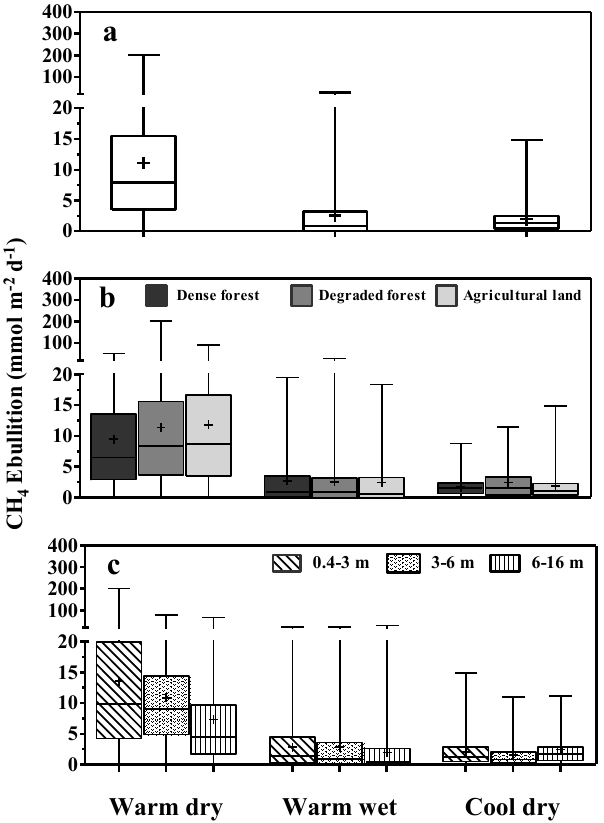
Figure 7. Ebullition measured by funnels for (a) the three different seasons, (b) the three major different flooded ecosystems (dense/medium forest, light/degraded forest, and agricultural land), and (c) three depth zones.